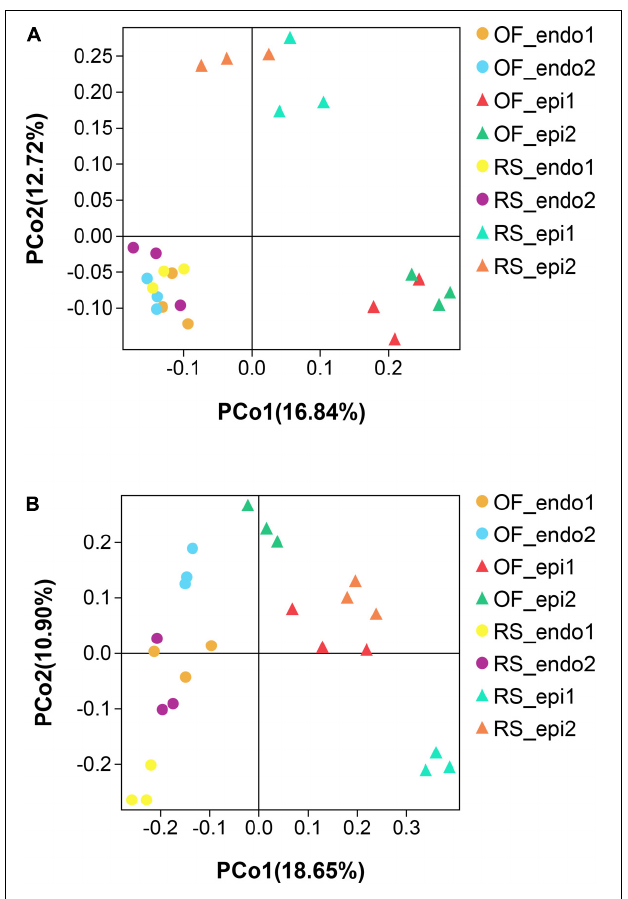
FIGURE 3 | Principal Coordinate Analysis (PCoA) analysis of bacterial (A) and fungal (B) communities in the different kiwifruit sample groups based on unweighted_unifrac distance. Samples labeled "RS" and "OF" designate rain-shelter (RS) and open-field (OF) samples, respectively. The terms "epi" and "endo" designate epiphytic and endophytic sample groups, respectively, and the designations "1" and "2" indicate “Hongyang” and “Cuiyu” cultivars, respectively. In the figure, to facilitate the distinction, we use circles to represent endophytes and upward triangles to represent epiphytes. The samples were taken in September